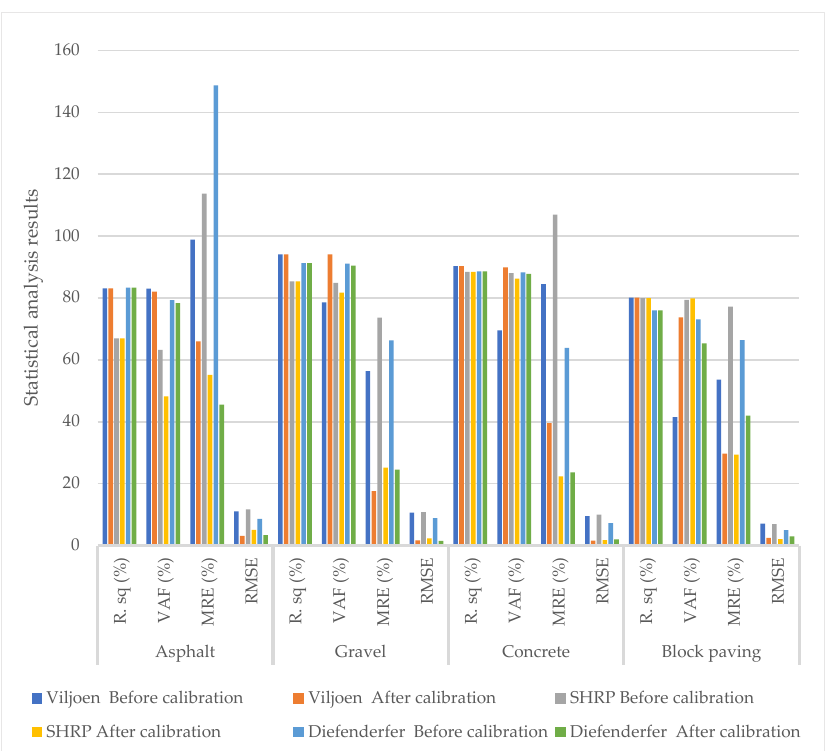
Figure 1. Comparison of statistical analysis results for uncalibrated and calibrated predicted maxi- mum temperatures.